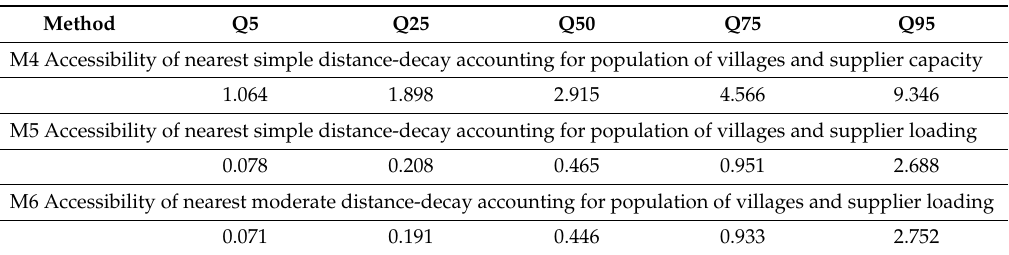
Table 6. Quintile accessibility of community care resources as measured using methods M4–M6 (estimated by 1000*capacity/people).